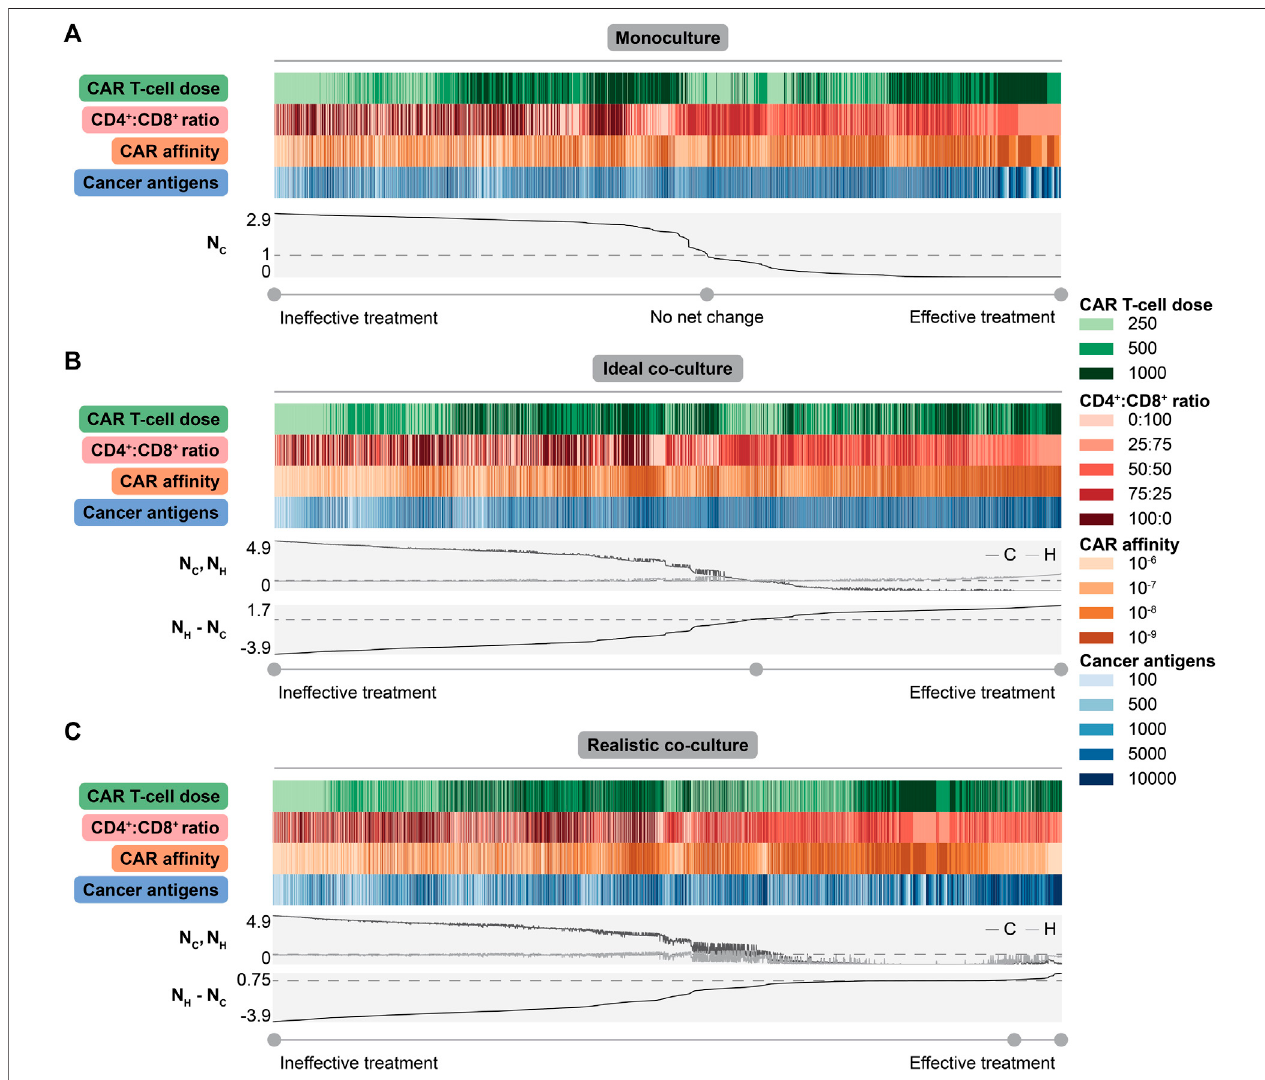
FIGURE 4 | Collective impact of CAR T-cell and tumor features on dish outcomes. (A) Heatmap showing values for each feature with line plots showing normalized live cancer cell count ( N C ) sorted from highest (left) to lowest (right). The dashed line indicates value of N C = 1, meaning no net change due to treatment. Values of N C > 1indicate netgrowth and valuesof N C < 1indicate netkilling. (B) Heatmapshowing valuesfor each feature withlineplotsshowingnormalized livecancer cell count ( N C ) and normalized live healthy cell count ( N H ) (dashed line indicates normalized live cell count of 1) and the difference in normalized live healthy and cancer cell counts ( N H − N C ) for each ideal co-culture simulation individually (dashed line indicates N H − N C = 0). The heatmap has been sorted from lowest (left) to highest (right) difference. All metricswere calculated at the fi nal time point (t =7 d). (C) Heatmap and normalized cell counts for realistic co-culture. Labels are consistent with panel B. Each feature is reported in the following units: CAR T-cell dose = number of CAR T-cells, CD4 + :CD8 + ratio = unitless, CAR af fi nity = M, cancer antigens = antigens/cell.